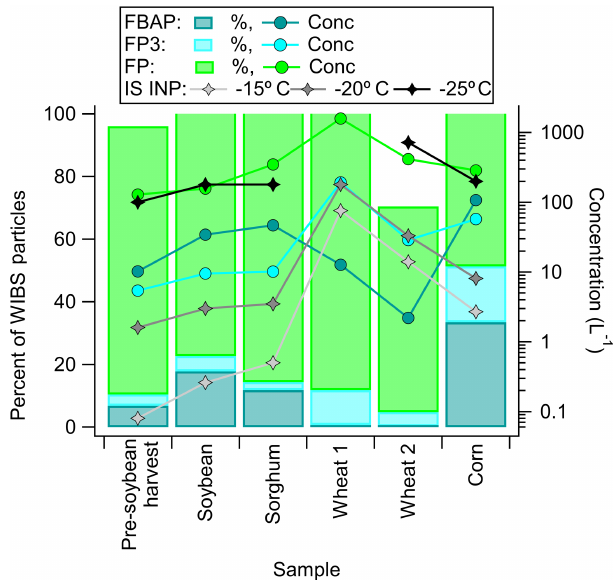
Figure 2. WIBS data showing the concentration (circle markers) and percentage (bars) of three different classes of fluorescent parti- cles (FP, FP3, and FBAP) during each harvest and one pre-soybean harvest period. The corn WIBS data were collected from the same field but on a different day than the corn IS data. The IS INP concen- trations for − 15 ◦ C (light grey), − 20 ◦ C (dark grey), and − 25 ◦ C (black) are shown in diamond markers for non-cyclone samples